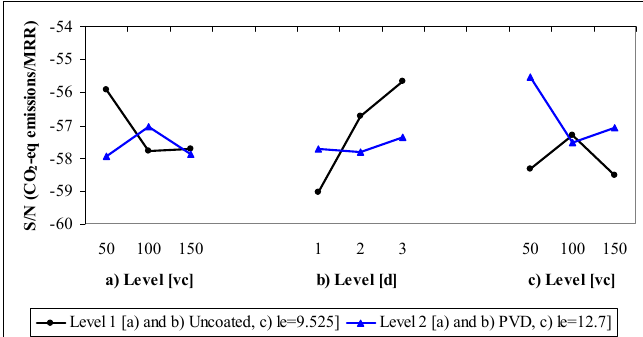
Figure 5. Values of the S/N ratios of the significant interactions for CO 2 -eq emissions/MRR.